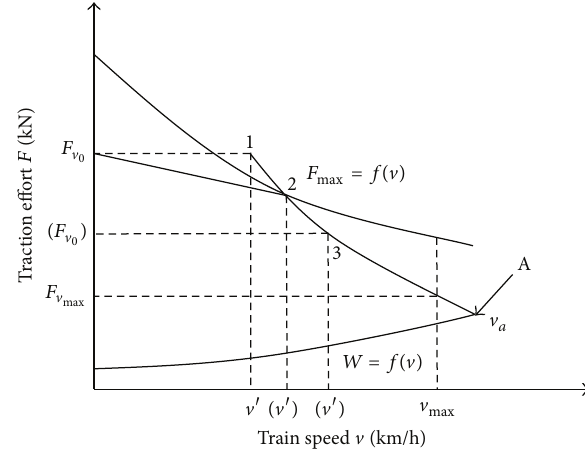
Figure 1: Diagram of traction property curve